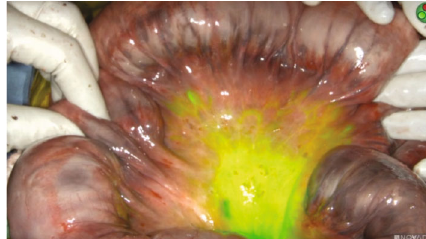
Figure 5: Nonperfused/ischemic colon (a) proximal to the splenic fl exure and well-perfused colon (b) distal to splenic fl exure.